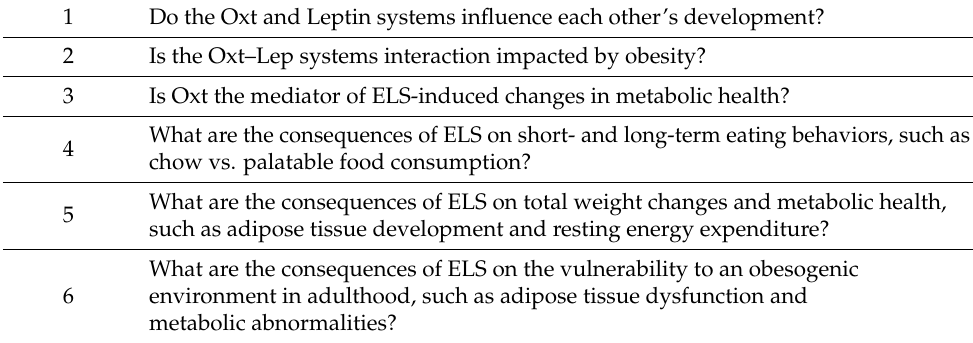
Table 1. Outstanding questions to be